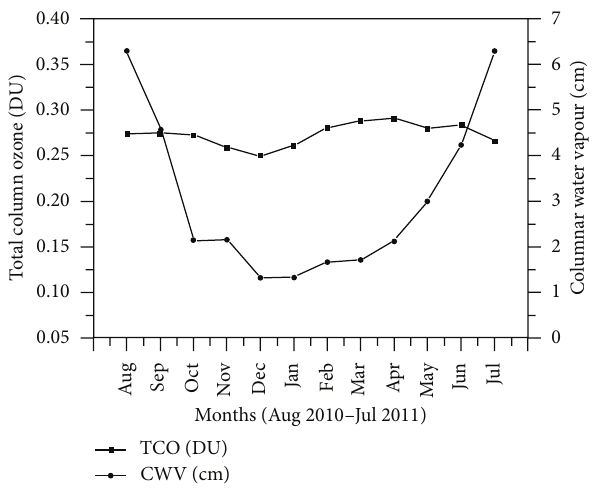
Figure 1: Monthly mean variation of total column ozone and column water vapour.